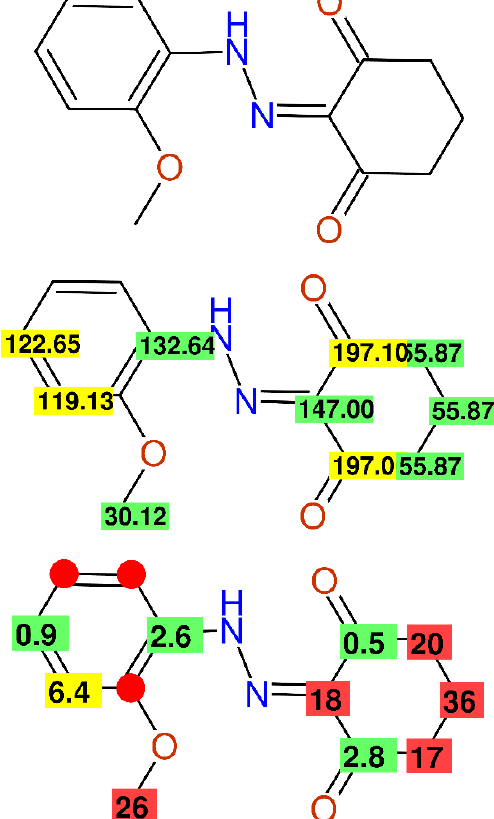
Figure 3. The 13 C-NMR data of compound L1 as published in [36], together with the differences between the experimental and predicted values.